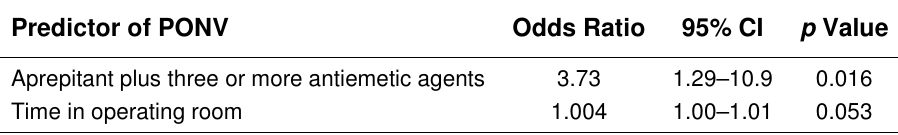
Predictors of PONV/PDNV Based on Multivariable Logistic